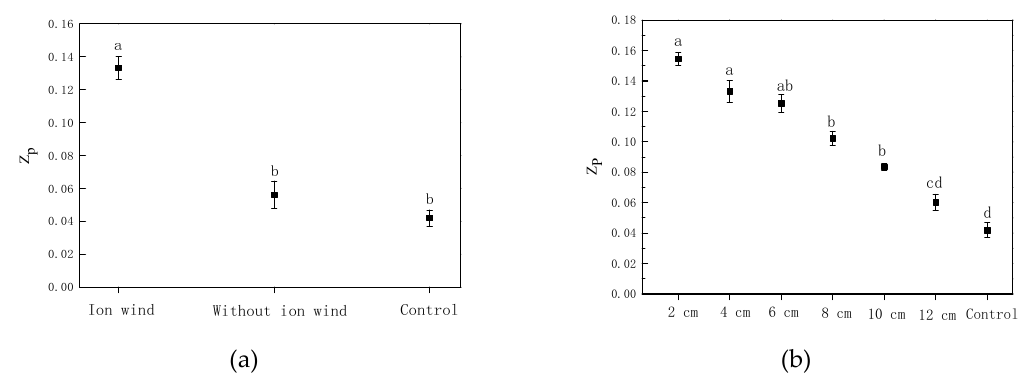
Figure 7. The electrical conductivity disintegration index of Chinese wolfberry fruits. ( a ) Ionic wind and without ionic wind; ( b ) different needle spacings. Data are shown as the mean ± SD. For each response, means with different lower-case letters are significantly different ( p ≤ 0.05).